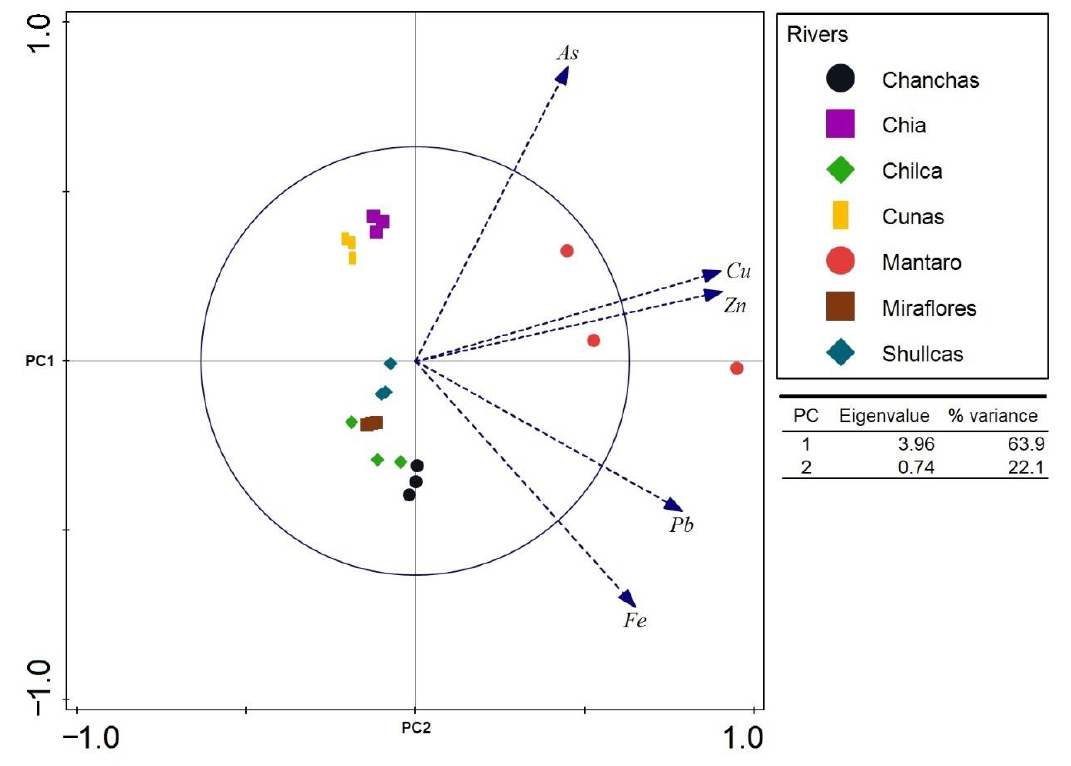
Figure 5. Perceptual map of the sampling sectors and heavy metal vectors in the principal component analysis.